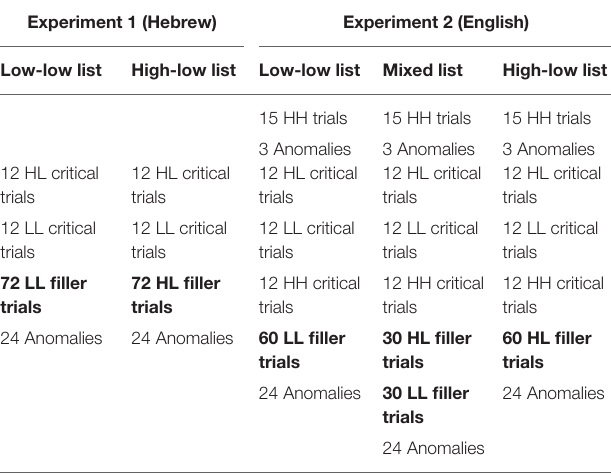
TABLE 2 | Trial composition in each list in Experiments 1 and